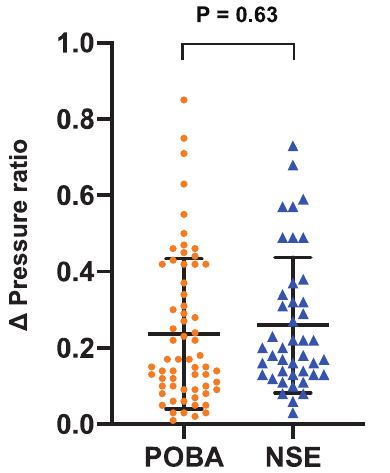
Fig 4. Δ Pressure ratio in the plain old balloon angioplasty (POBA) group and the non-slip element (NSE) group. The data are given as the mean ± SD.